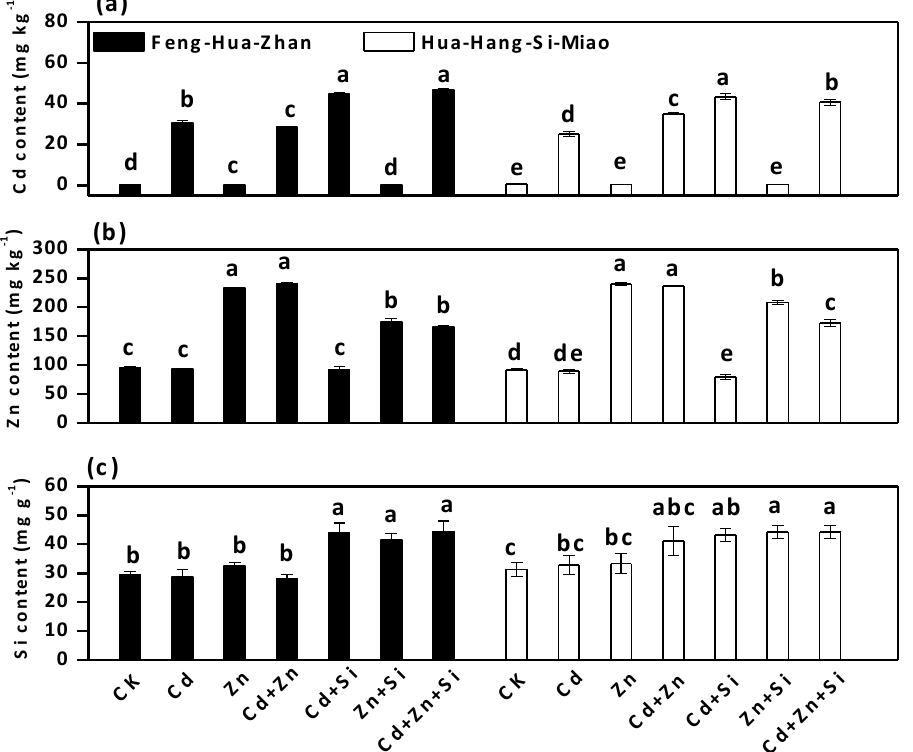
Figure 7. Effect of Si on available element concentrations in soil: ( a ) Cd content; ( b ) Zn content; Figure+7. "Effect"of"Si"on"available"element"concentrations"in"soil:"( a )"Cd"content;"( b )"Zn"content;"( c ):"Si" ( c ): Si content. Error bars indicate standard deviations ( n = 4). Bars with different letters are significantly content."Error"bars"indicate"standard"deviations"( n "="4)."Bars"with"different"letters"are"significantly" different ( p < 0.05) according to Duncan’s different"( p% <"0.05)"according"to"Duncan’s"MRT."